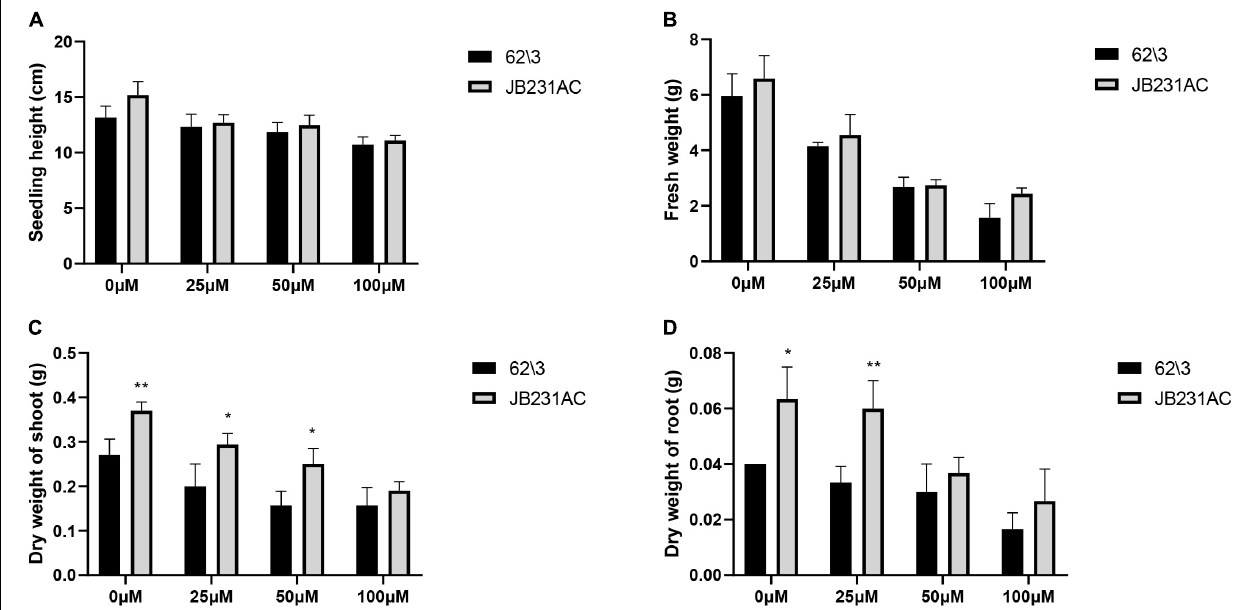
FIGURE 2 | Vegetative performance of 62\3 and JB231AC. (A–D) Growth-related indices of the seedlings, seedling height (A) , fresh weigh (B) , dry weight of shoot (C) and dry weight of root (D) . For (A–D) the statistical analyses were conducted using all the performance data of 62\3 and JB231AC under Cd stress. Data presented are the means ( n = 3), and error bars denote the standard deviations. The asterisk represent the significant difference between 62\3 and JB231AC under one same Cd stress. * P < 0.05, ** P <